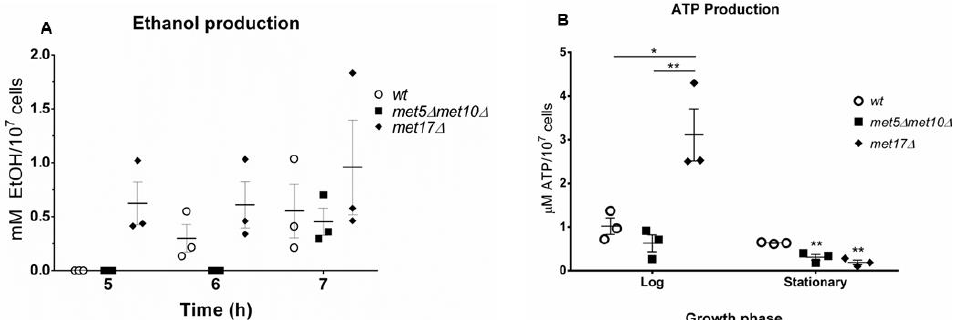
hours of growing, we found that the met17 ∆ strain maintained the elevated rate of oxy- gen consumption. This result suggests that endogenously accumulated H 2 S promotes oxygen consumption.